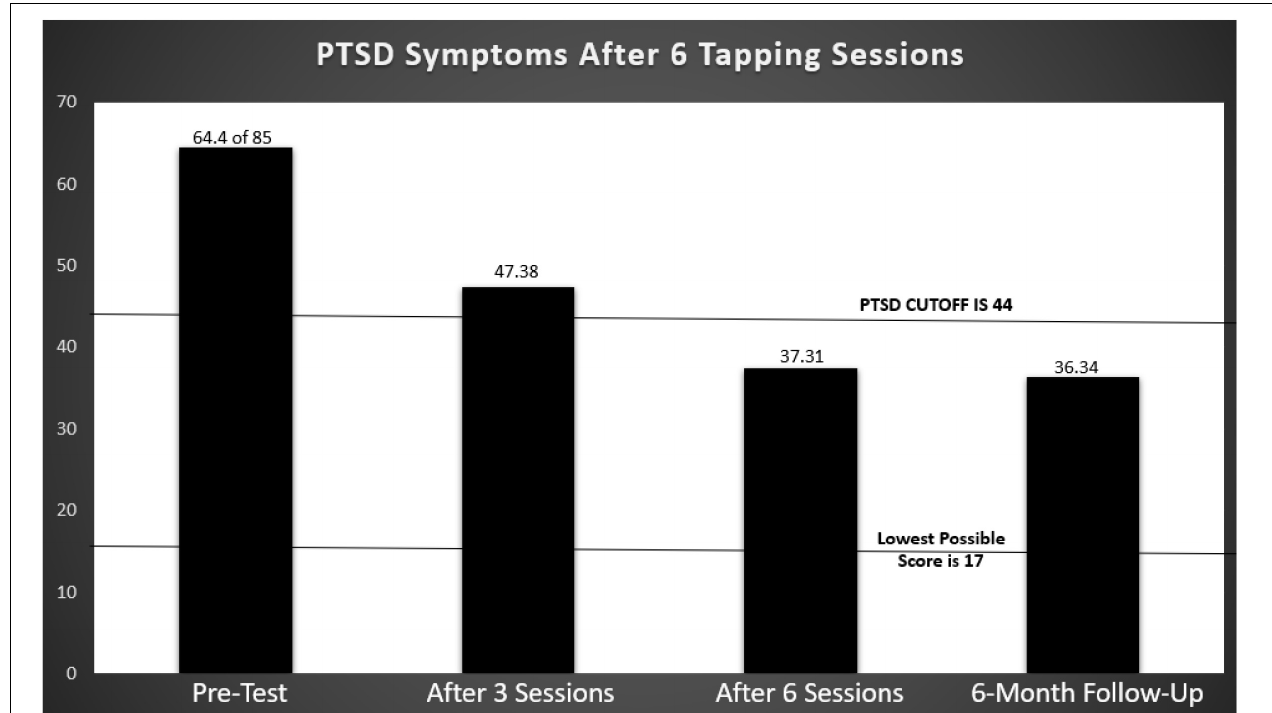
FIGURE 1 | Post Traumatic Stress Disorder Checklist-Military (PCL-M) scores before and after PTSD tapping treatments with 49 combat veterans. Based on Church et al.